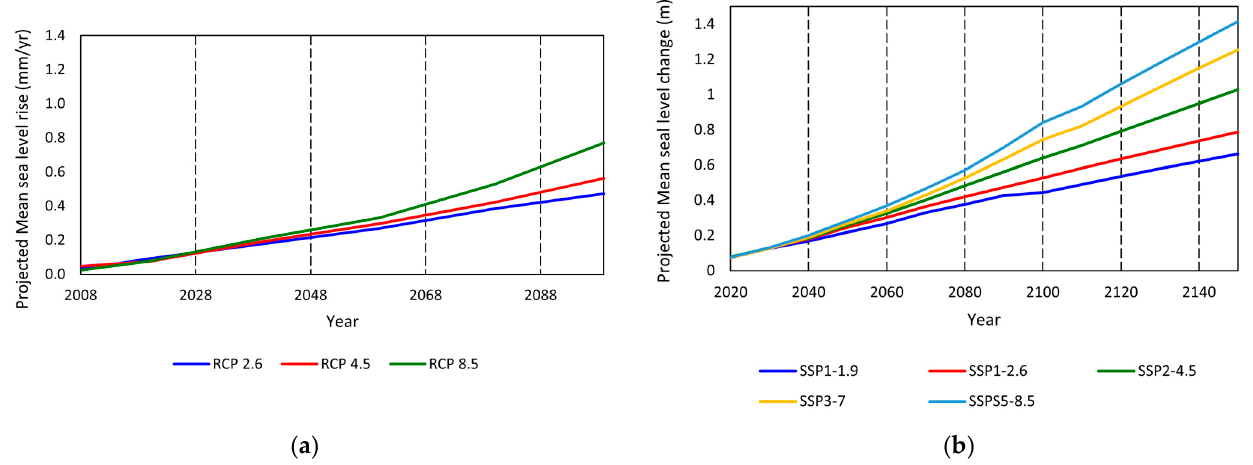
Figure 5. ( a ) Projected Mean Sea level change in coastal Greece according to RCP scenarios [71] ( b ). Projected Mean Sea level change at Messolonghi lagoon according to the SSP scenarios [72]